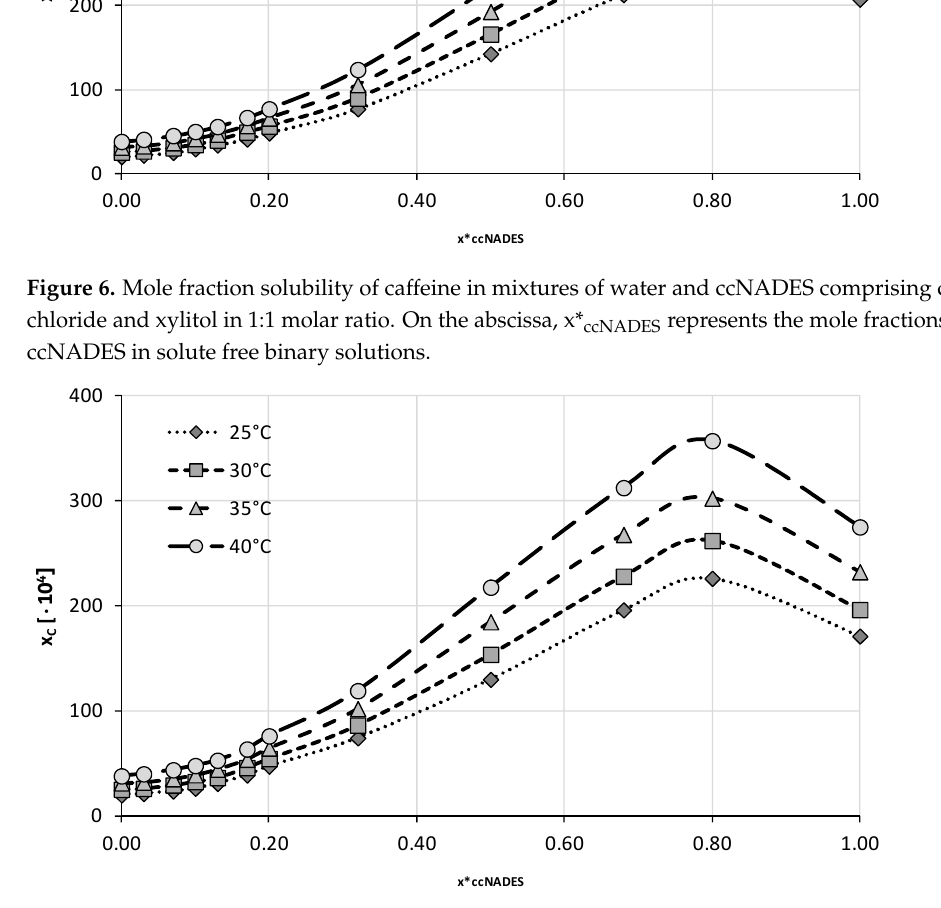
Figure 7. Mole fraction solubility of caffeine in mixtures of water and ccNADES comprising choline chloride and glucose in 1:1 molar ratio. On the abscissa, x* ccNADES represents the mole fractions of the ccNADES in solute free binary solutions.